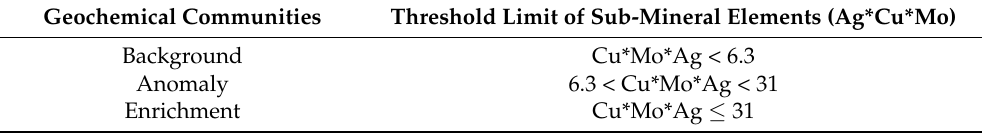
Table 4. Geochemical threshold limits of sub-mineral elements based on C-A multifractal analysis.